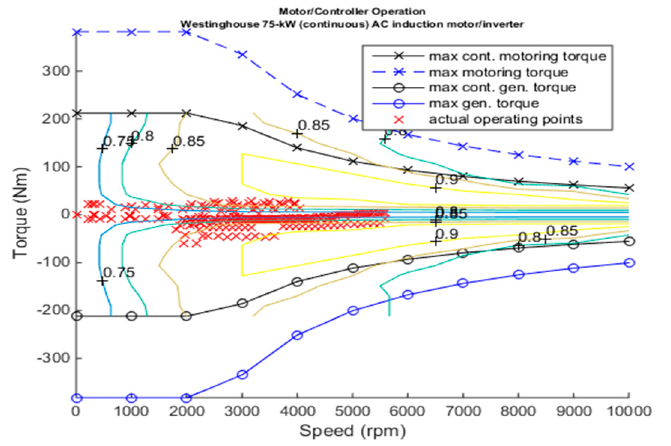
Figure 21. Motor torque-speed.